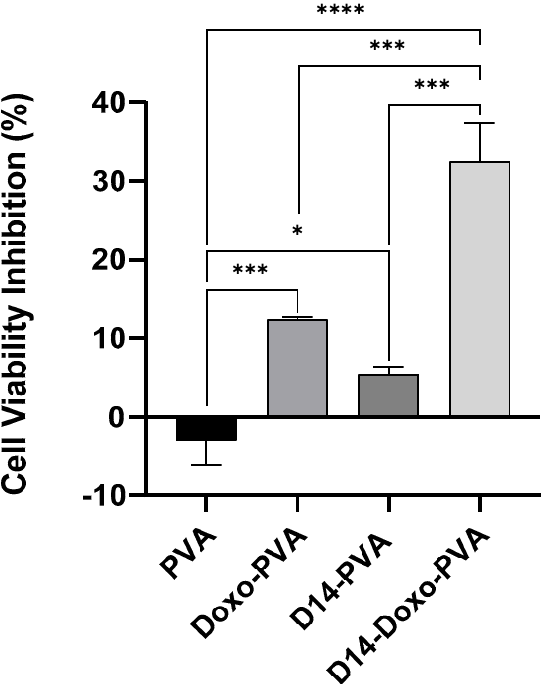
Figure 6. MTT assay to measure cell viability of U2OS cells treated for 24 h with PVA sphere containing only D14 (~8 µ g/mL) or doxo (~4 µ g/mL), PVA sphere loaded with both drugs D14 + doxo and PVA empty spheres. The cell viability % is obtained by the ratio of the treated cells to the control and data is shown as mean +- standard deviation. Statistical analysis was performed by using one-way ANOVA followed by Tukey post-test and significant results were considered when *, *** < 0.001 and **** < 0.0001.